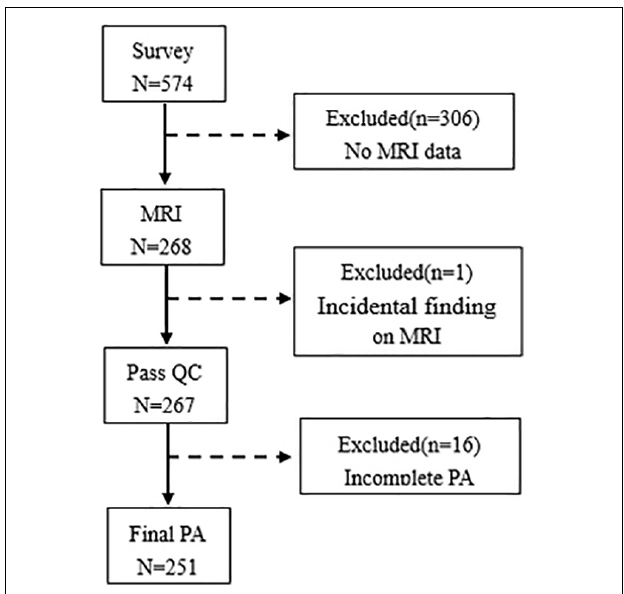
FIGURE 1 | Flowchart of data exclusion is given in this study. QC, quality control; PA, physical